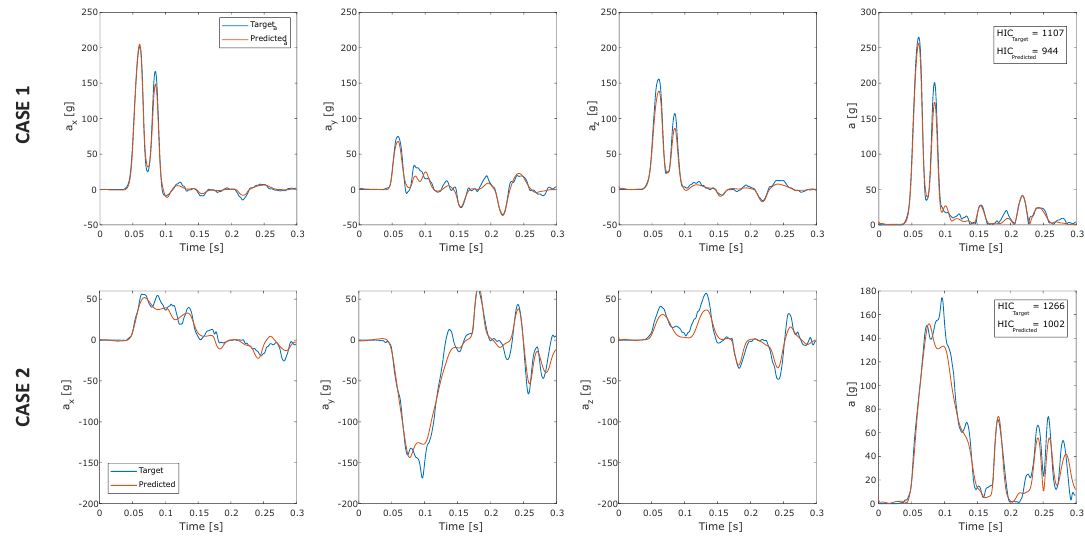
Figure 5. Linear acceleration prediction using the deep neural network model. The dANN reproduces the acceleration component’s shape and the peak values in both cases well (Figure 5). Peak values and HIC were calculated on the entire testing dataset (300 simulations). Scatter plots in Figure 6 show the comparison between peak values of the target and estimated acceleration components. Peaks of the Z-component had the best overall performance with R 2 = 0.972. Parameters calculated on the resultant acceleration, i.e., peak value and HIC, had similar R 2 high values, confirming the strong learning ability of dANNs (Figure 7).